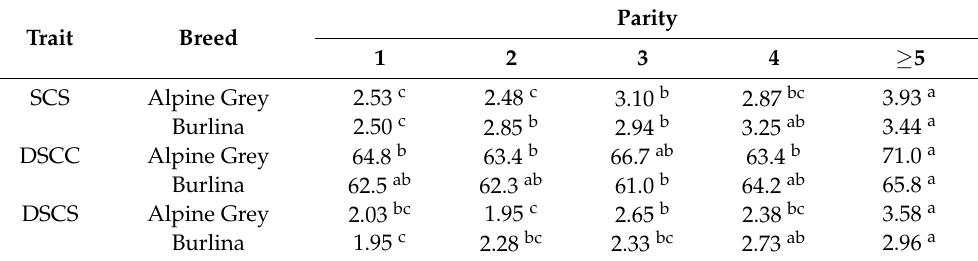
Table 3. Least squares means 1 of udder health traits 2 for the interaction between parity and breed. Values with different superscripts within row are significantly different ( p ≤ 0.05).